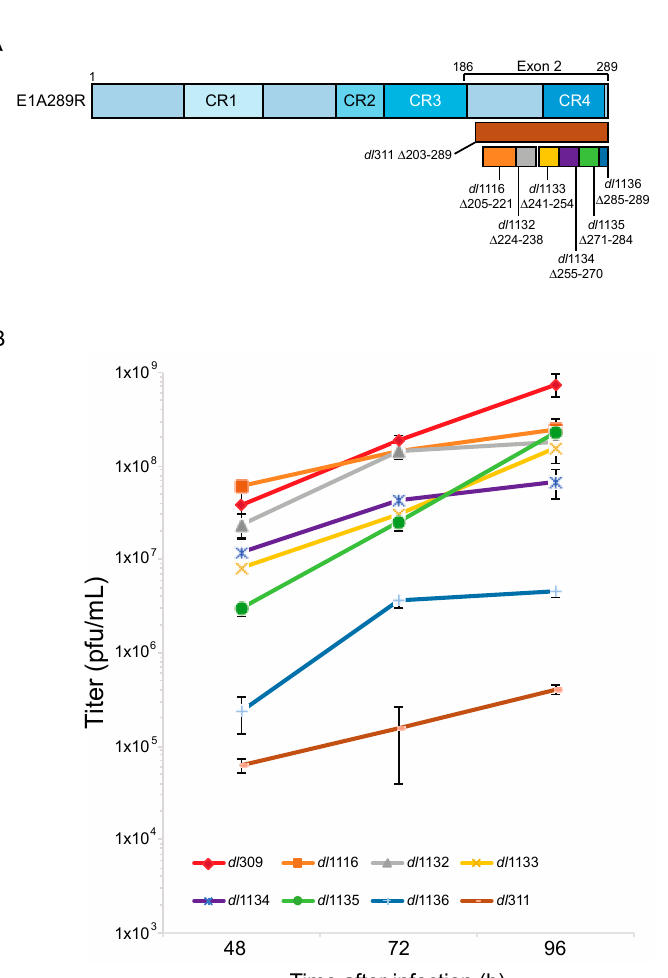
Figure 1. Deletions within the E1A C-terminus affect virus growth. ( A ) Schematic representation of HAdV5 E1A289R protein with locations of deletion mutants used in this study. Numbers indicate amino acids. ( B ) Contact inhibited WI-38 cells were infected with the indicated HAdV5 deletion mutants at a MOI of 100. Virus titers were determined at the indicated times points by performing plaque assays on 293 cells. At 48 h the differences in growth between dl 309 and dl 311, dl 1135 and dl 1136 were statistically significant with p < 0.0005, while others were not significant. At 72 h, the differences in growth between dl 309 and dl 1116 and dl 1132 were not significant but were found to be statistically significant for all the other viruses with p < 0.0001. At 96 h, the differences in growth between dl 309 and all the mutants tested were statistically significant with p < 0.0003. Error bars represent standard deviation of biological replicates, n = 3.